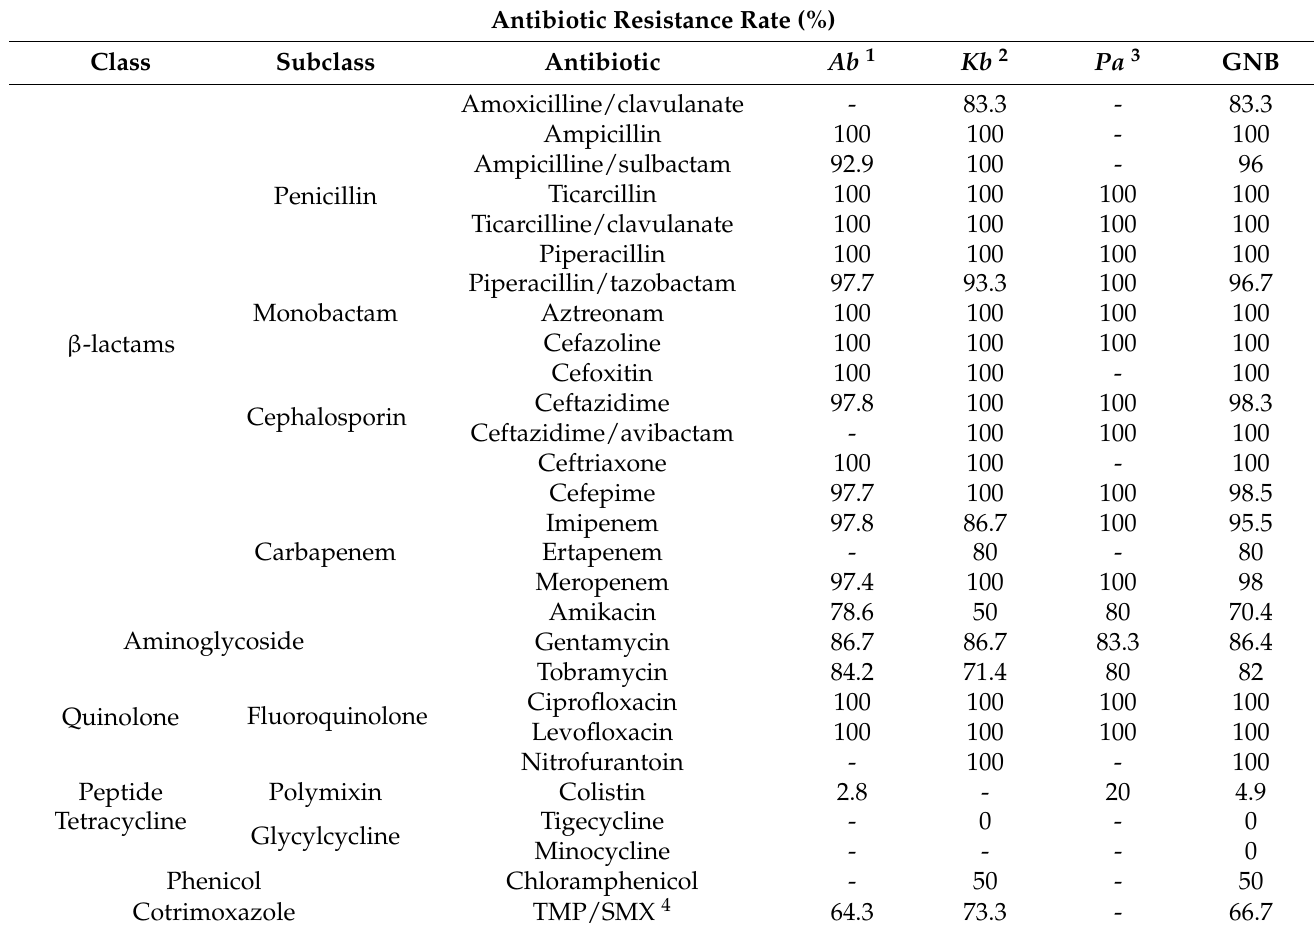
Table 4. Antibiotic resistance rate of multi-resistant GNB ( n =